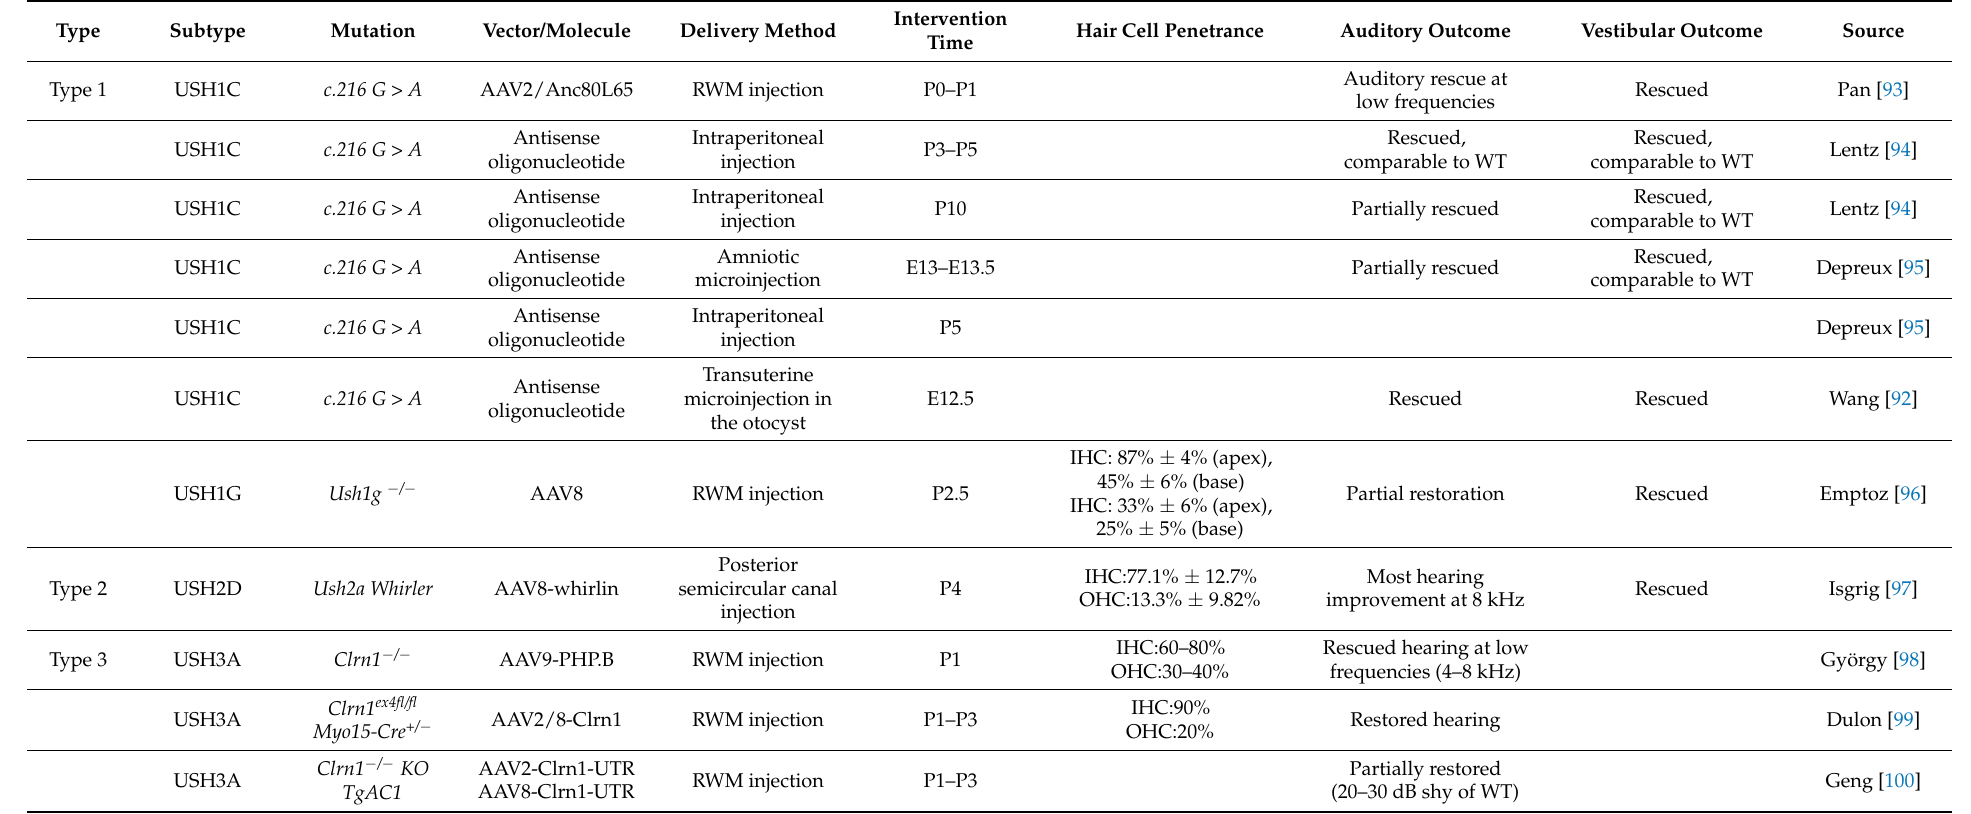
Table 3. Overview of animal-modeled therapies for Usher syndrome in the inner